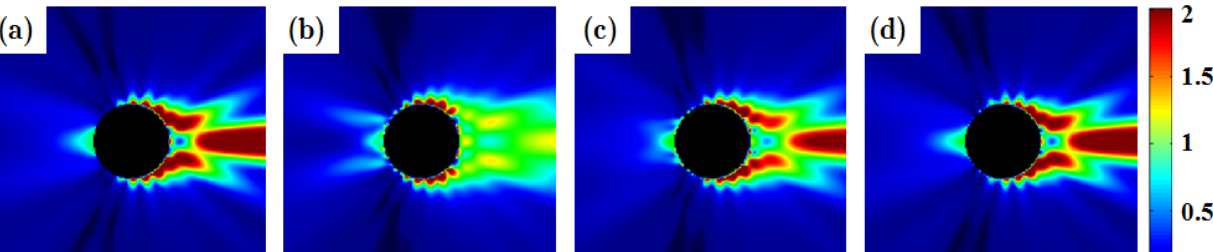
Figure 4. Calculated E scattered intensity distributions for an infinitely-long Ag cylinder y using: ( a ) Mie theory; ( b ) Staircase model; ( c ) EP model; ( d ) S-EP model (black region represents the cylinder); ( e ) Angular intensity distributions on contour C of radius 1 : 2 a